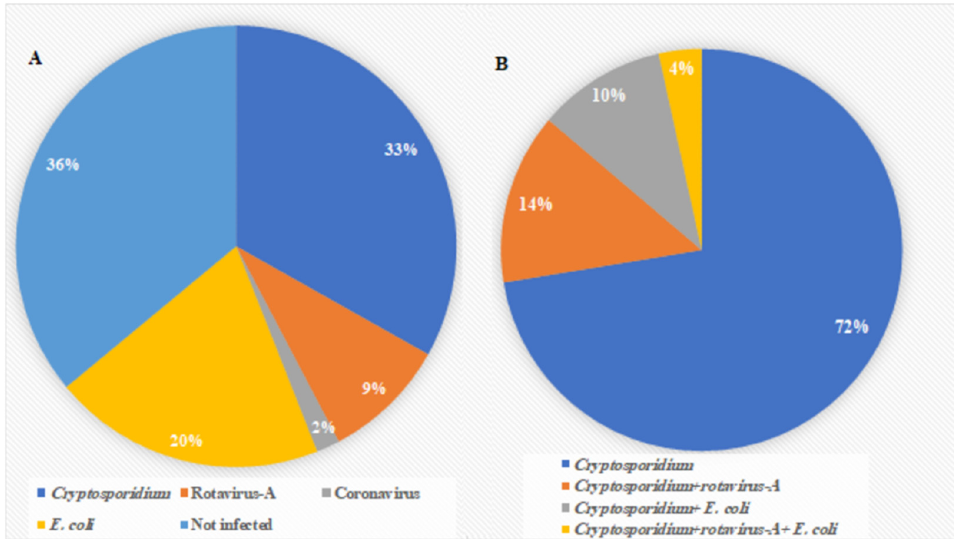
Figure 1. Results of rapid IC assay: ( A ) Prevalence of the four pathogens ( Cryptosporidium, rotavirus- A, coronavirus, and E. coli ) detected in 175 preweaned calves. ( B ) Prevalence of Cryptosporidium mono-infection and co-infections with other pathogens detected by IC.